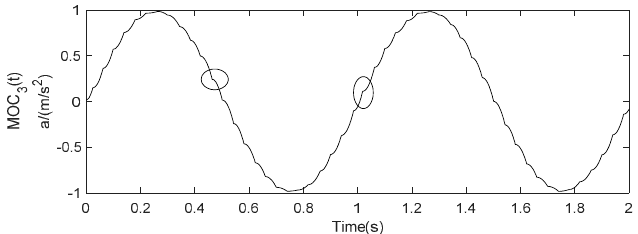
Figure 3. The enlarged image of the third MOC component MOC 3 ( t ).